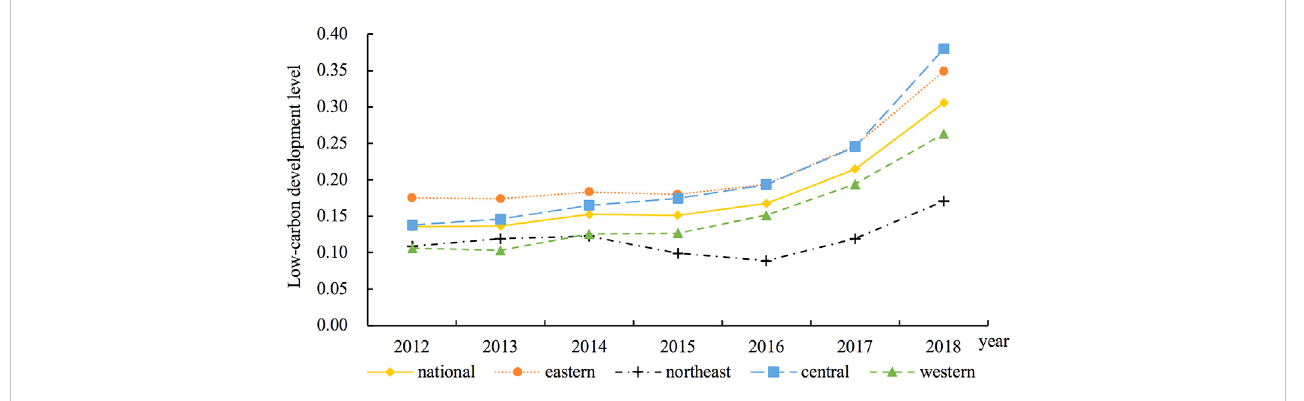
FIGURE 1 The evolution trend of the average value of low-carbon development of manufacturing industry in china and its four